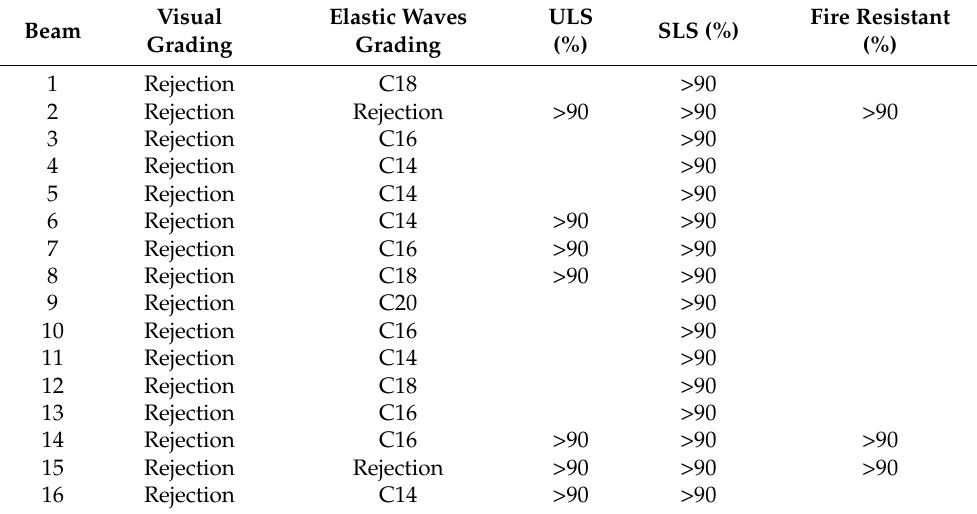
Table 6. Summary of characteristics considered in non-destructive testing multi-analysis. ULS, SLS and Fire resistant indicate the % of load capacity exhausted. A percentage of 90 was established as the admissibility threshold for the ULS, SLS and Fire resistance features. Non-rejection strength class was established as the admissibility threshold for strength grading, both in visual and elastic wave